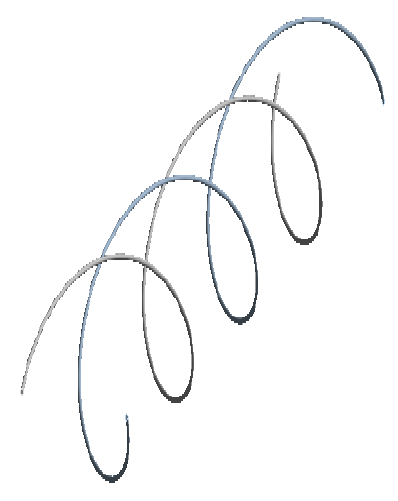
Figure 9. Helical arrangement